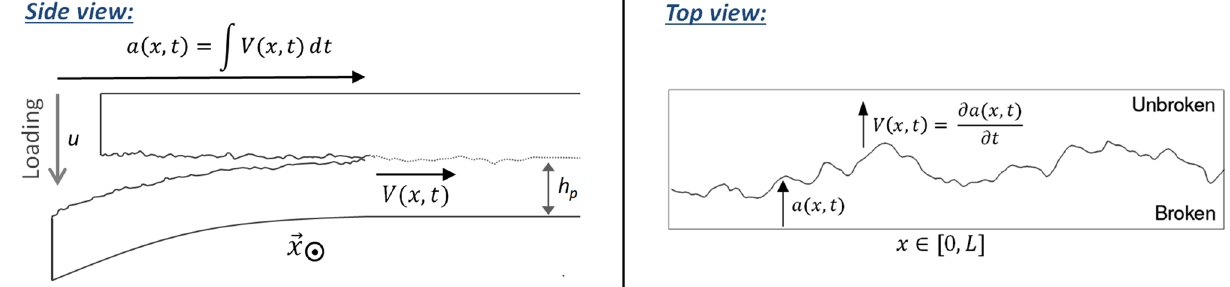
Figure 1. (Left): Separation of two rugous and sintered PMMA plates, as reported by Tallakstad et al. 28 (side view). The rugosity of the (quasi-plane) interface is here massively exaggerated (the plates are centimetres thick while the standard deviation in the interface topography is less than a micrometer 43 ). A local position of the front has an advancement a ( x , t ) and a velocity V ( x , t ). The out of frame coordinate is x and t is the time variable. (Right): top view, showing the crack font roughness, which arises from the disorder in the interface’s fracture